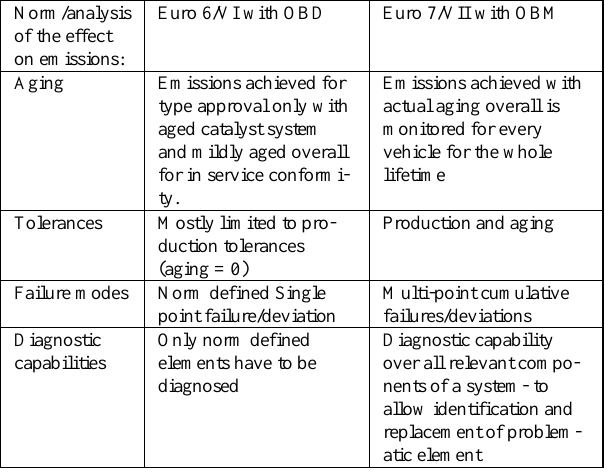
Table 1. Comparison of analysis depth required for Euro6 and 7 norms Norm/analysis of the effect